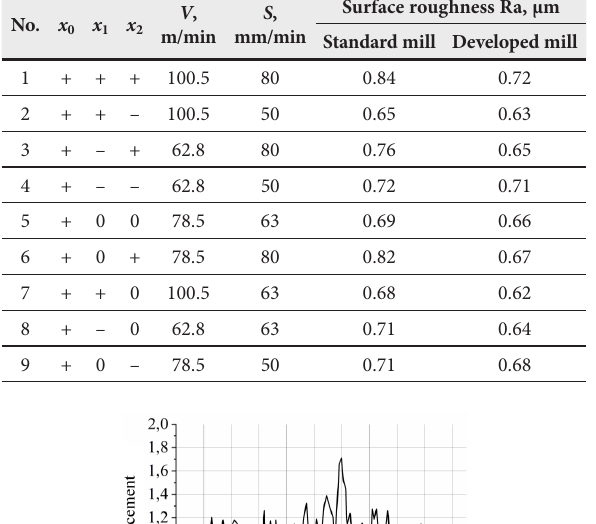
Results of the surface roughness study